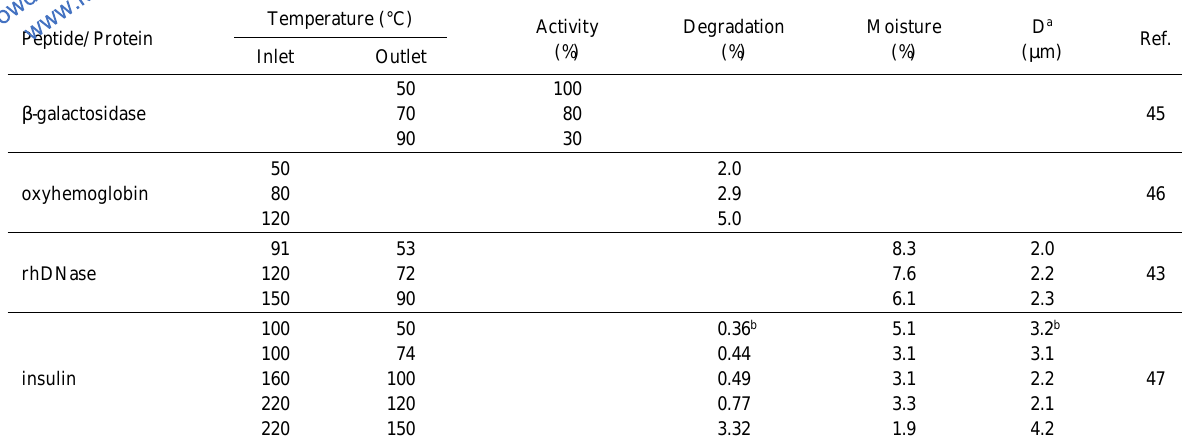
a Geometric or aerodynamic diameter. b High-molecular-weight